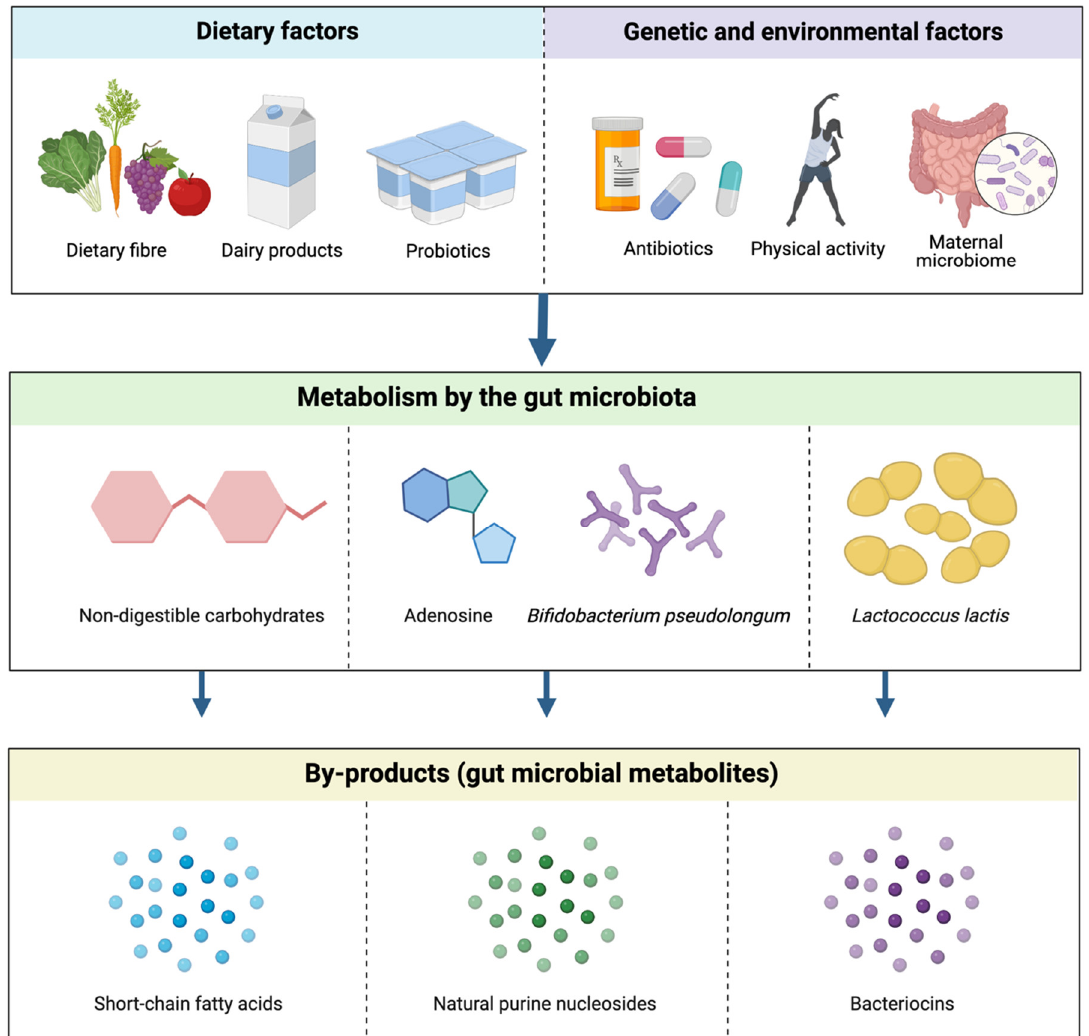
Figure 2. The effect of dietary and other epigenetic factors on the production of gut microbial metabolites. These factors possess precursor compounds and bacterial species, i.e., non-digestible carbohydrates, adenosine and Bifidobacterium pseudolongum and Lactococcus lactis , that undergo metabolic processes to synthesise common gut microbial metabolites, SCFAs, natural purine nucleosides, and bacteriocins, respectively [4] .